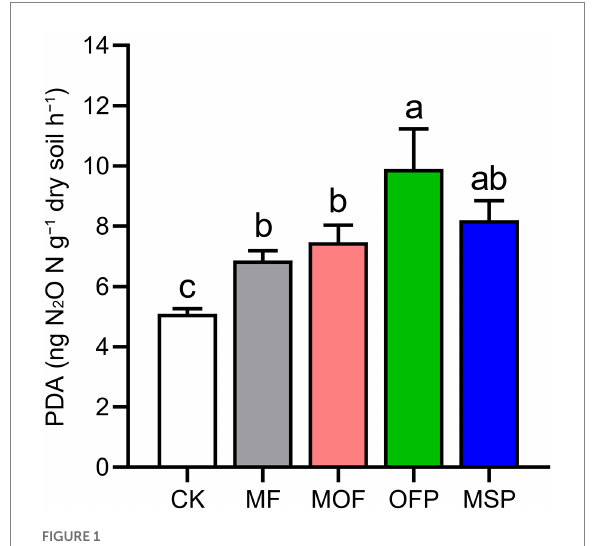
FIGURE 1 Potential denitrification activity (PDA) under different fertilization treatments. Bars ( n = 3) with different lowercase letters indicate significant differences based on Tukey’s HSD test ( p < 0.05). CK, No fertilization; MF, mineral fertilizer; MOF, mineral fertilizer plus commercial organic fertilizer; OFP, commercial organic fertilizer; MSP, maize